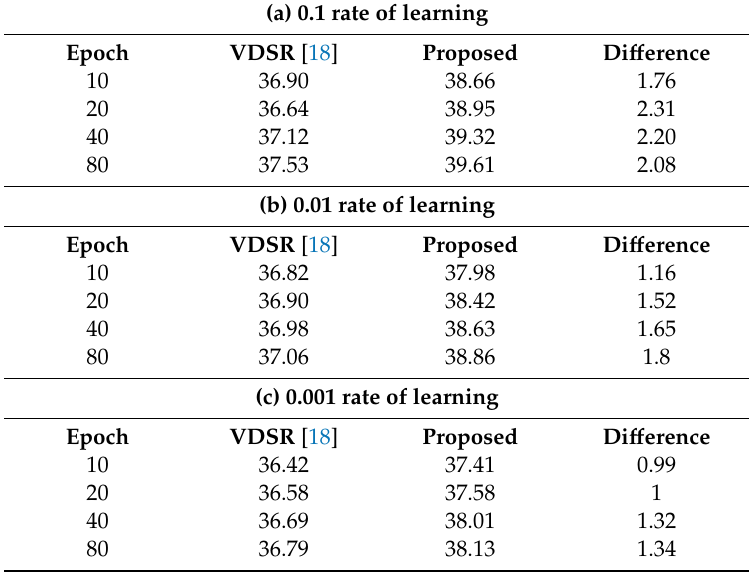
Figure 7. Visual comparison for the Barbara image at the scale-up factor of 2. Figure 8. Visual comparison for the tiger image at the scale-up factor of 3.